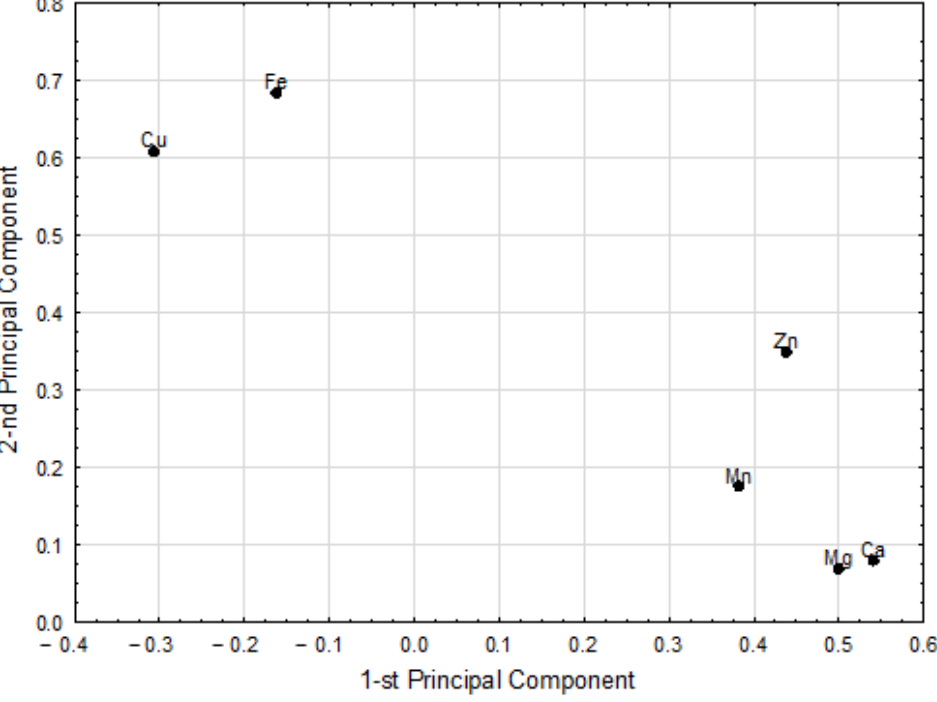
Figure 3. The weights of the first two principal components of the PCA model. Table 2. Correlation weights based on principal components in the PCA model (only correlation weights with absolute values higher than 0.100 are